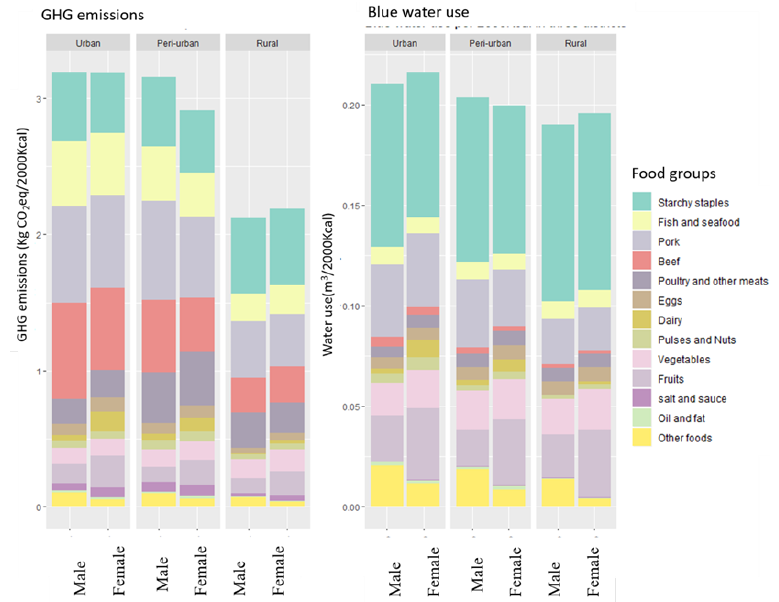
Figure 6. Normalized environmental footprints (per 2000 Kcal) for male and female household members by district.